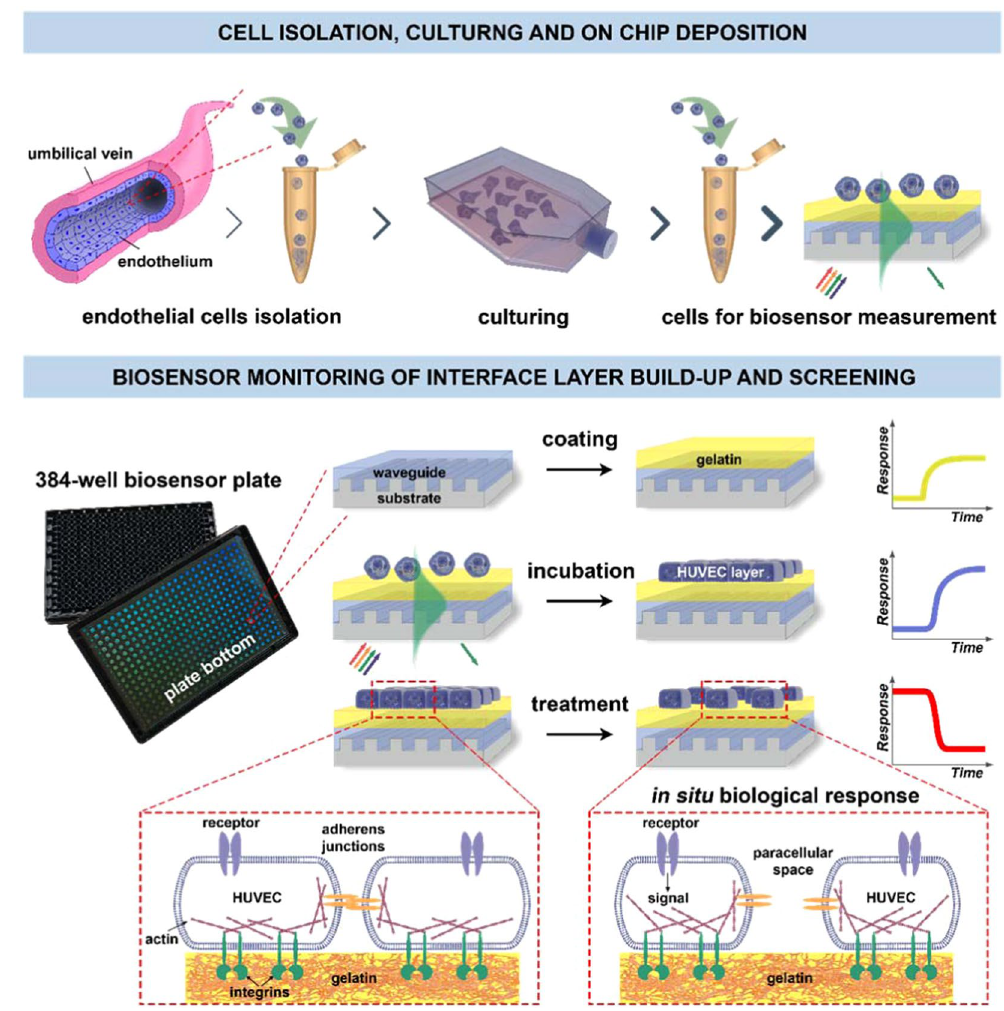
Figure 1. Schematic overview of the proposed EnLaB measurement setup. Upper part: cell preparation steps (primary cell isolation, culturing, transferring onto the sensor chip surface). The incoupled waveguide mode intensity profile is shown in green color. The exponentially decaying evanescent field of the mode senses the adhering cells. The waveguide mode is excited by illuminating the grating structure from below using a broad range of wavelengths. The resonant wavelength excites the waveguide mode which – after propagating a short distance inside the waveguide – couples out into the direction of the substrate (shown in green). The lower part illustrates the steps of the biosensor measurements and typically obtained biosensor responses (the detected shifts in the resonant wavelength): coating of the chip with gelatin, following with cell attachment to the gelatin surface, and subsequent cell treatment by the studied molecular compounds (screening). Illustration of the biological effect of the treatment is highlighted in dashed